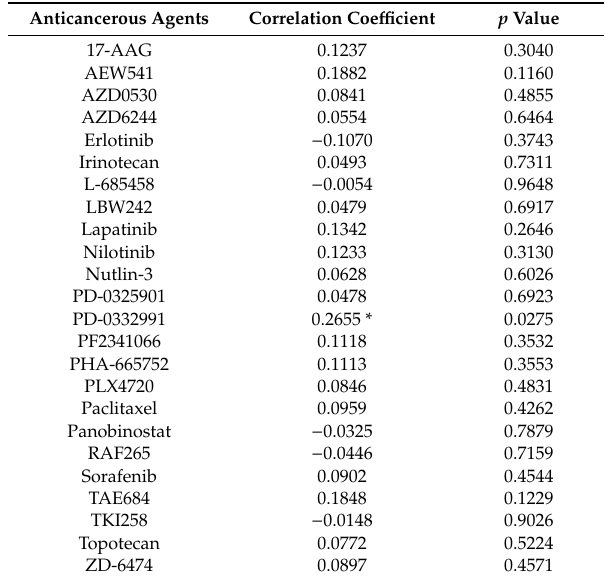
Figure 7. Correlation between RND1 expression and sensitivity to anticancer agents in hematological and lymphoid tumor cells. Using the CCLE database, correlations between quantitative data were determined as in Table 2. Two-sided p -values of less than 0.05 were considered statistically significant. All statistical analyses were performed using STATA 12.0 software. Table 3. Correlations between RND3 expression and sensitivity to anticancerous agents in hematological and lymphoid tumor cells.